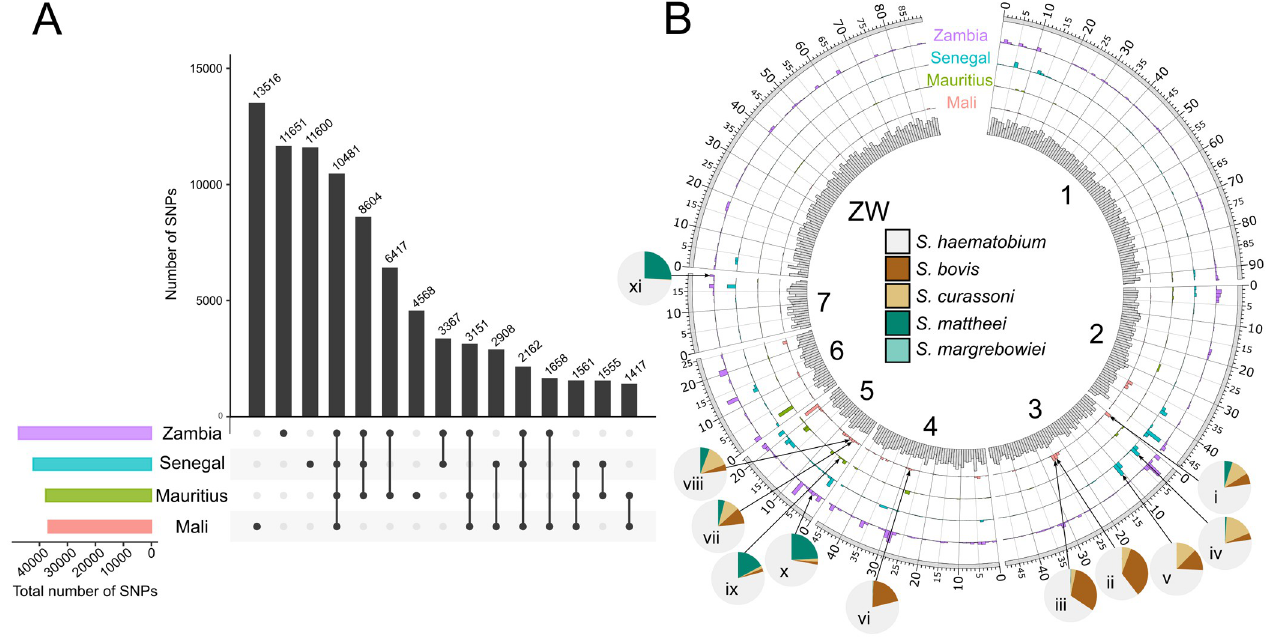
Fig 2. Analysis of single nucleotide polymorphisms (SNPs) of four individual male Schistosoma haematobium worms from distinct geographic location. A Intersections of unique or shared, fixed SNPs within the predicted coding regions for isolates from Zambia, Senegal, Mauritius or Mali. Total numbers of SNPs within individual samples are indicated by distinctly-coloured bars (bottom left). B For all samples, density and localisation of SNPs in the S . haematobium reference genome are shown as histograms in the same colour. Gene densities are shown in a histogram on the innermost track, divided into 1Mb sections along each chromosome. For each sample, SNP-rich regions of which > 20% resembled a genomic reference other than S . haematobium are labelled (i-xi), and the distribution of matches against the genome of other schistosome species is displayed as a pie chart.